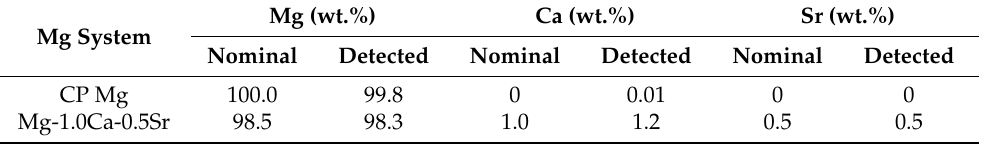
Table 3. Elemental comparison between the nominal content and EDS-analyzed